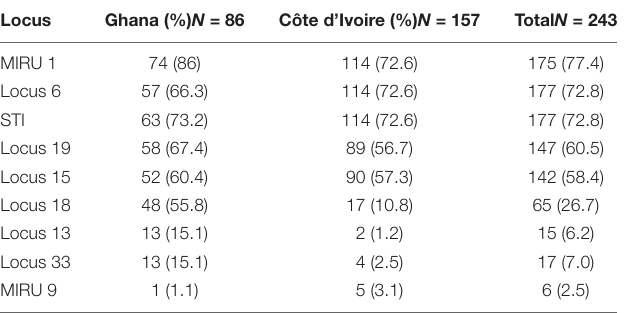
TABLE 3A | Frequency distribution of successful amplification at the different loci for the clinical samples. Locus Ghana (%) N = 86 Côte d’Ivoire (%) N = 157 Total N = 243